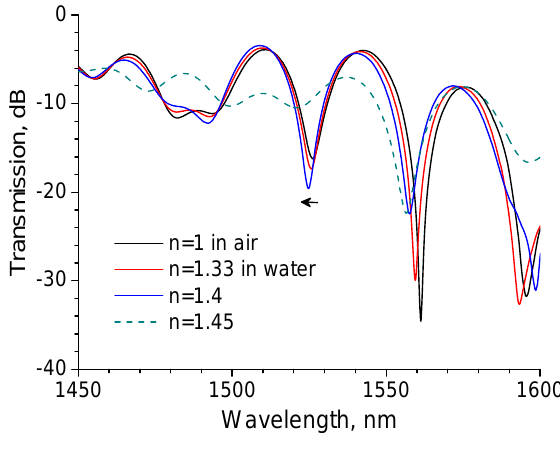
Figure 4. Transmission spectra of a 20-mm-long straight LPG surrounded by a medium having a refractive index that is lower than that of silica.